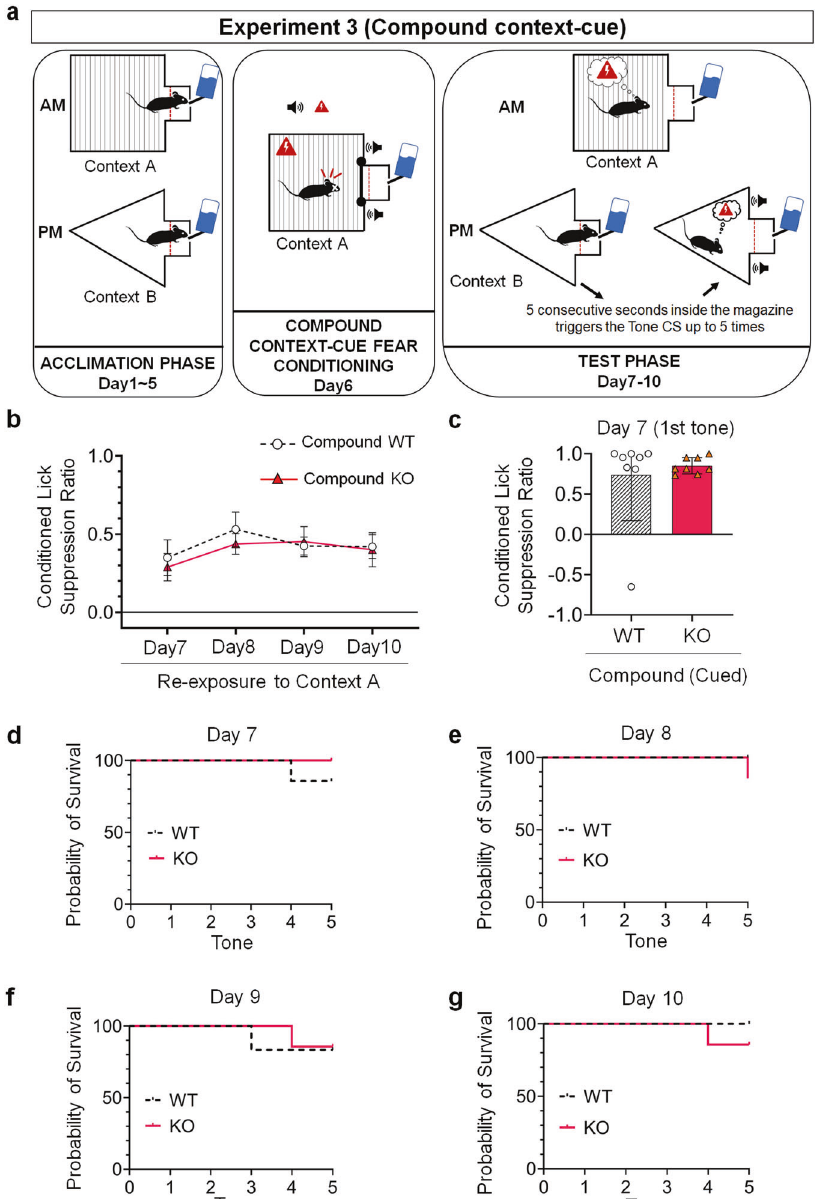
Fig. 4 Compound context-cue fear responses. a Schematic drawing of each of the three phases of the compound context-cue condition lick suppression task. b Contextual conditioned lick suppression performance in WT mice (Compound WT Group; N = 7) compared to KO mice (Compound KO Group; N = 7) tested from Day 7 to Day 10 in the same context (Context A) where they received the fear conditioning session. Two-way analysis of variance (ANOVA) for repeated measures. Data are represented as means and error bars represent ±SEM. c Cued conditioned lick suppression performance in WT mice (Compound WT Group; N = 7) compared to KO mice (Compound KO Group; N = 7) during the fi rst tone delivery at Day 7 in a different context (Context B) from that of the conditioning phase (Context A). Two-tailed t-test for independent samples. Black full lines and dashed black lines of violin plots represent medians and quartiles ( fi rst and third) respectively. d – g Percentage probability of survival rate between WT (Compound WT Group; N = 7) and KO mice (Compound KO Group; N = 7) tested from Day 7 to Day 10. Log-rank (Mantel-Cox) tests.